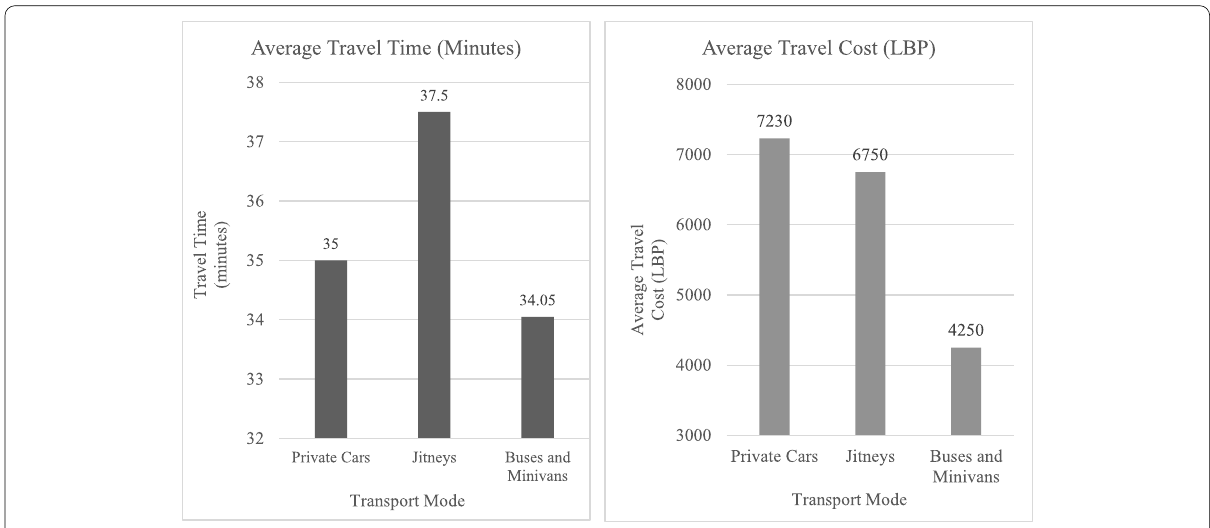
Fig. 8 Average of stated travel times and travel costs for different transport modes